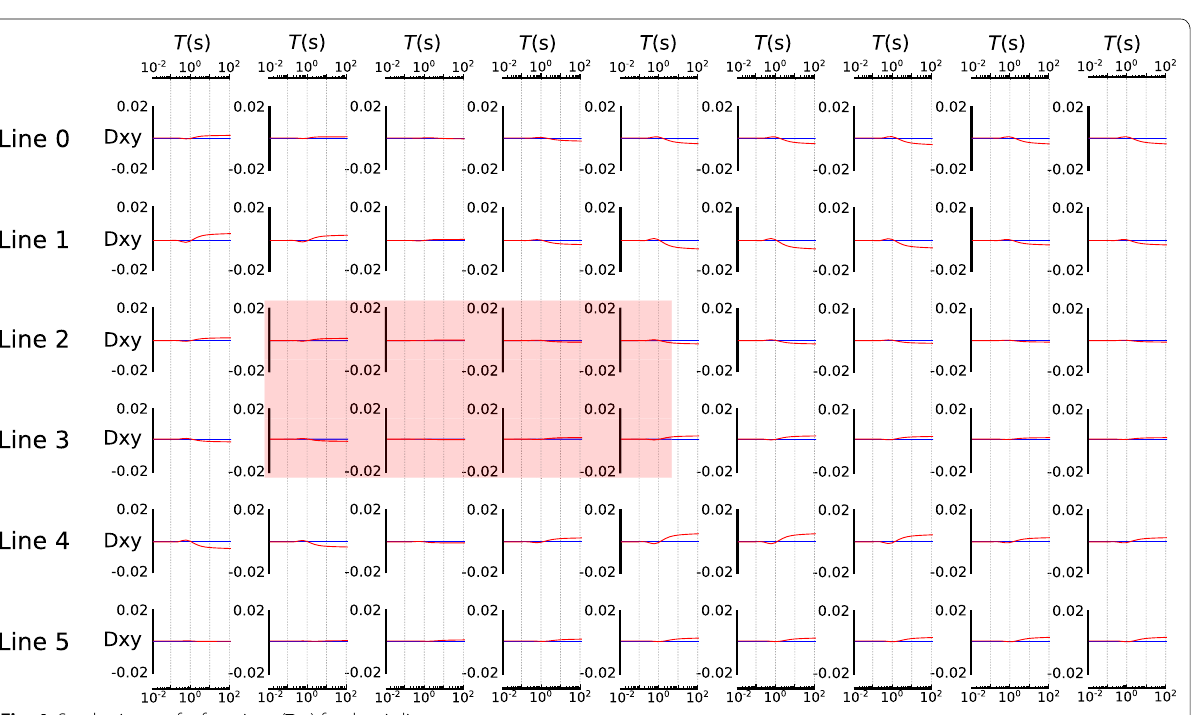
Fig. 4 Synthetic transfer functions ( D xy ) for the six